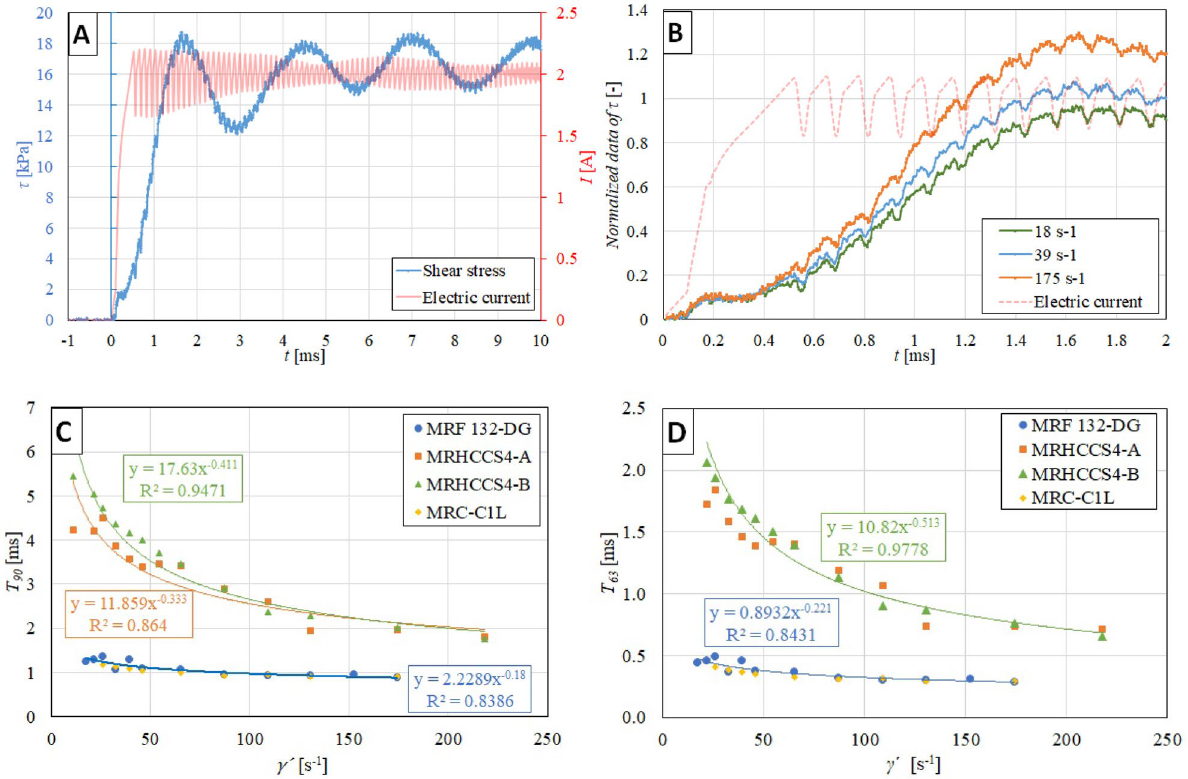
Figure 5. ( A ) The selected shear stress and electric current course over time for shear rate 39 s −1 and MRF 132- DG, ( B ) the effect of shear rate on the normalized course of shear stress in MRF 132-DG; The effect of shear rate on response time 90% ( C ), 63% ( D ) for different MR fluids at the same electric current excitation of 2